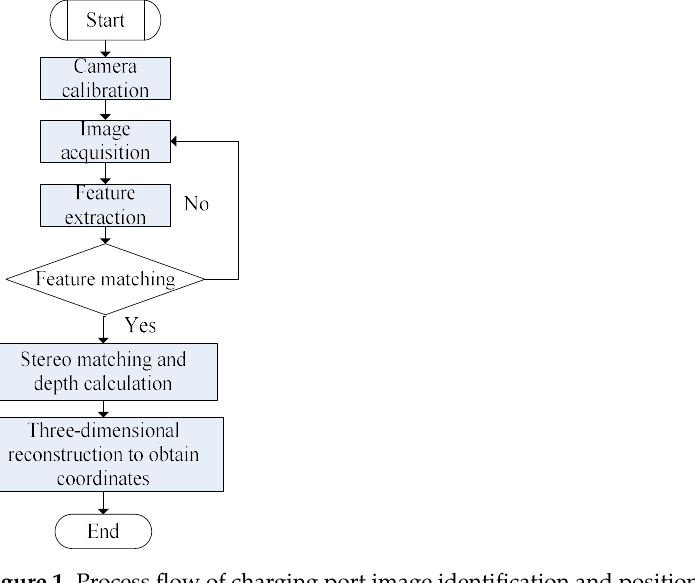
Figure 1. Process flow of charging port image identification and positioning system.